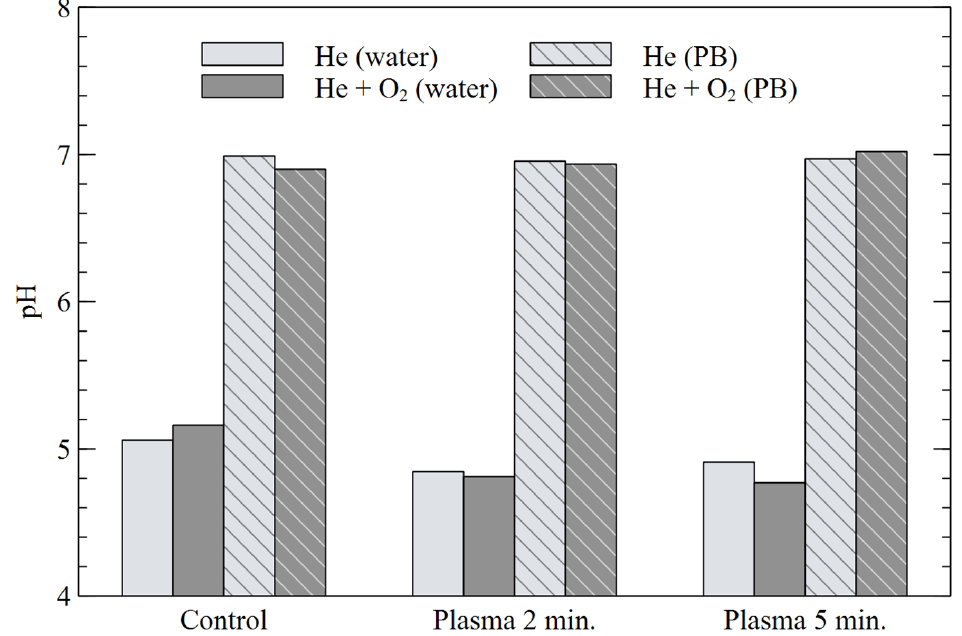
Figure 7. Measurements of pH of water and PB for different plasma treatment times.